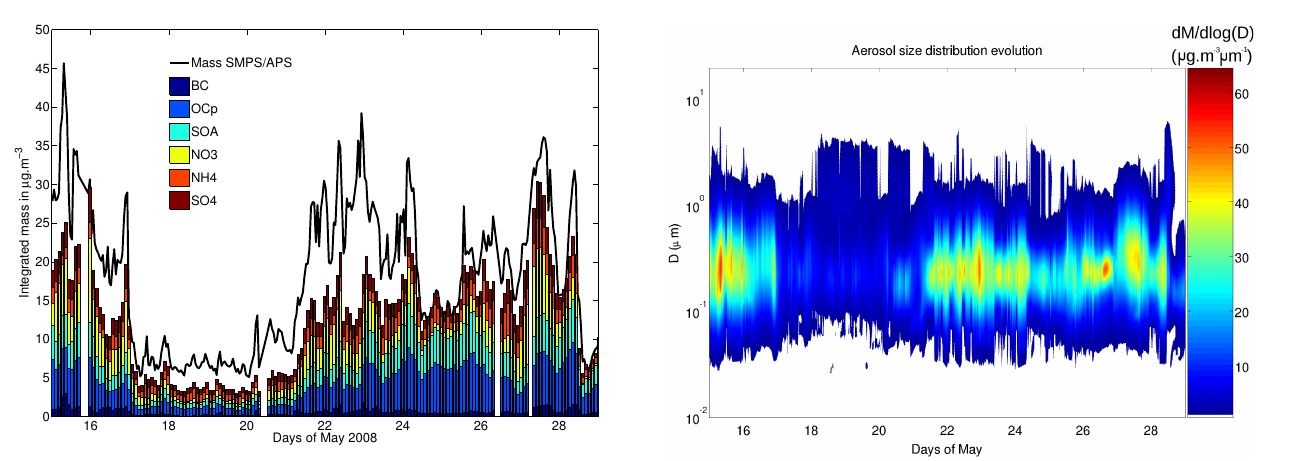
Fig. 9. Evolution of aerosol size distribution fits obtained from SMPS+APS during the fourteen days of measurement.